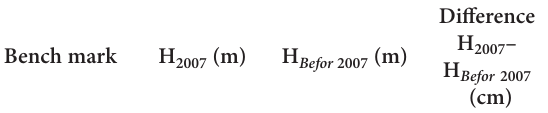
Table 7. Data on the height of bench marks for